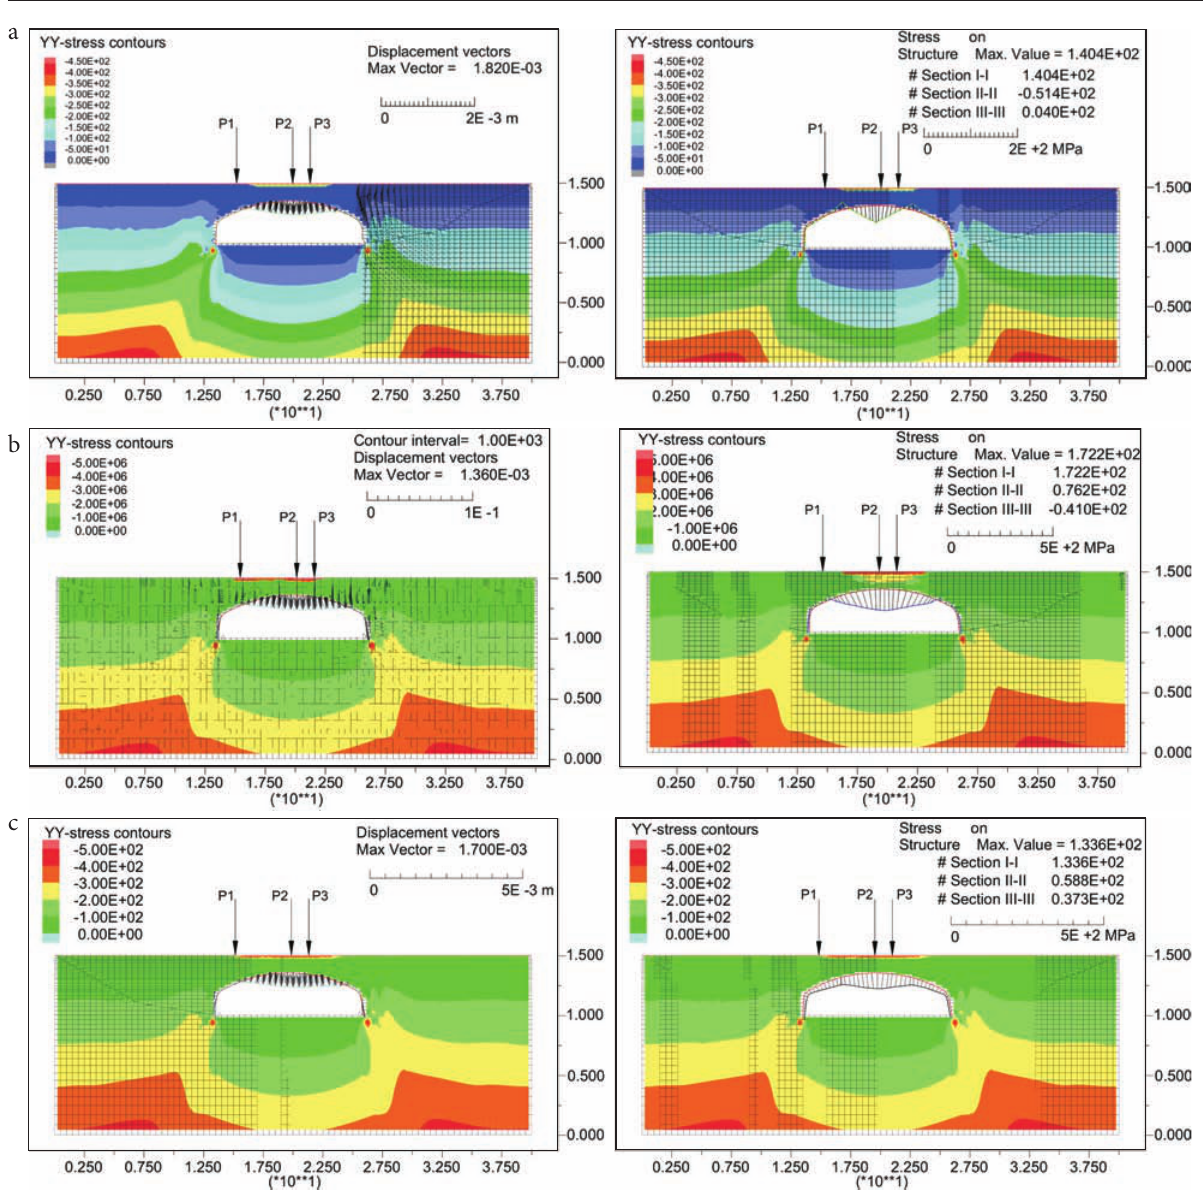
fig. 8. Graphs of max deflections and normal stresses in shell structure obtained from 3 load schemes: a – I; b – II; c – III Table 2. Max measured and calculated strain values (10 –6 ) in longitudinal direction in selected 3 sections of steel shell structure obtained at bottom and top of corrugation under static load